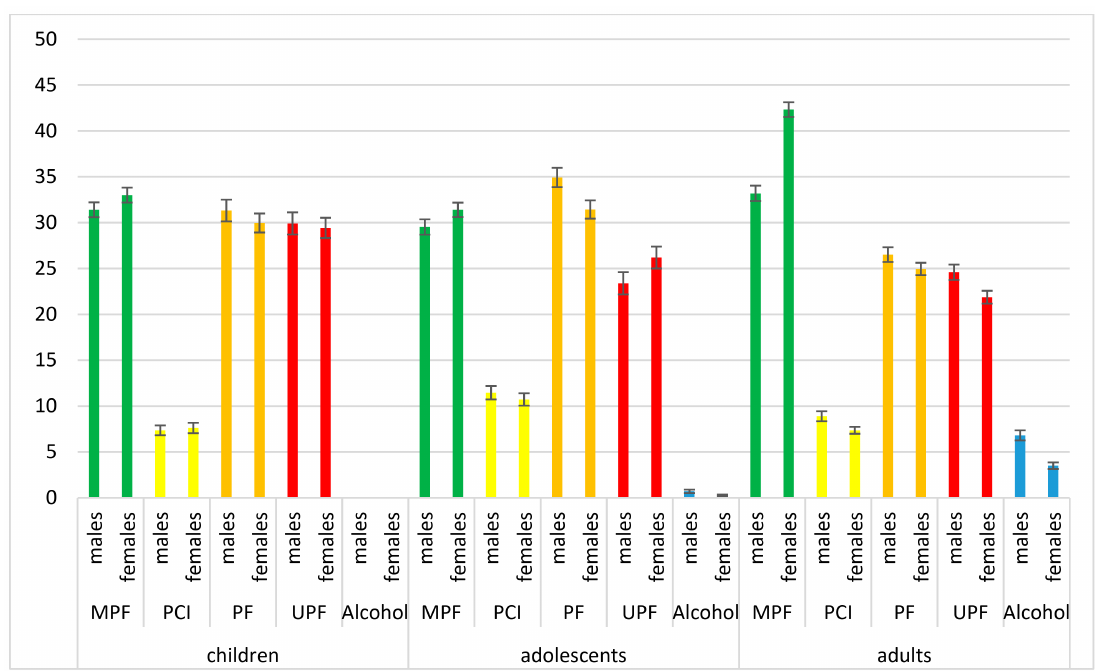
Figure 1. Contribution (average % ± SE) of unprocessed / minimally processed foods (MPF),